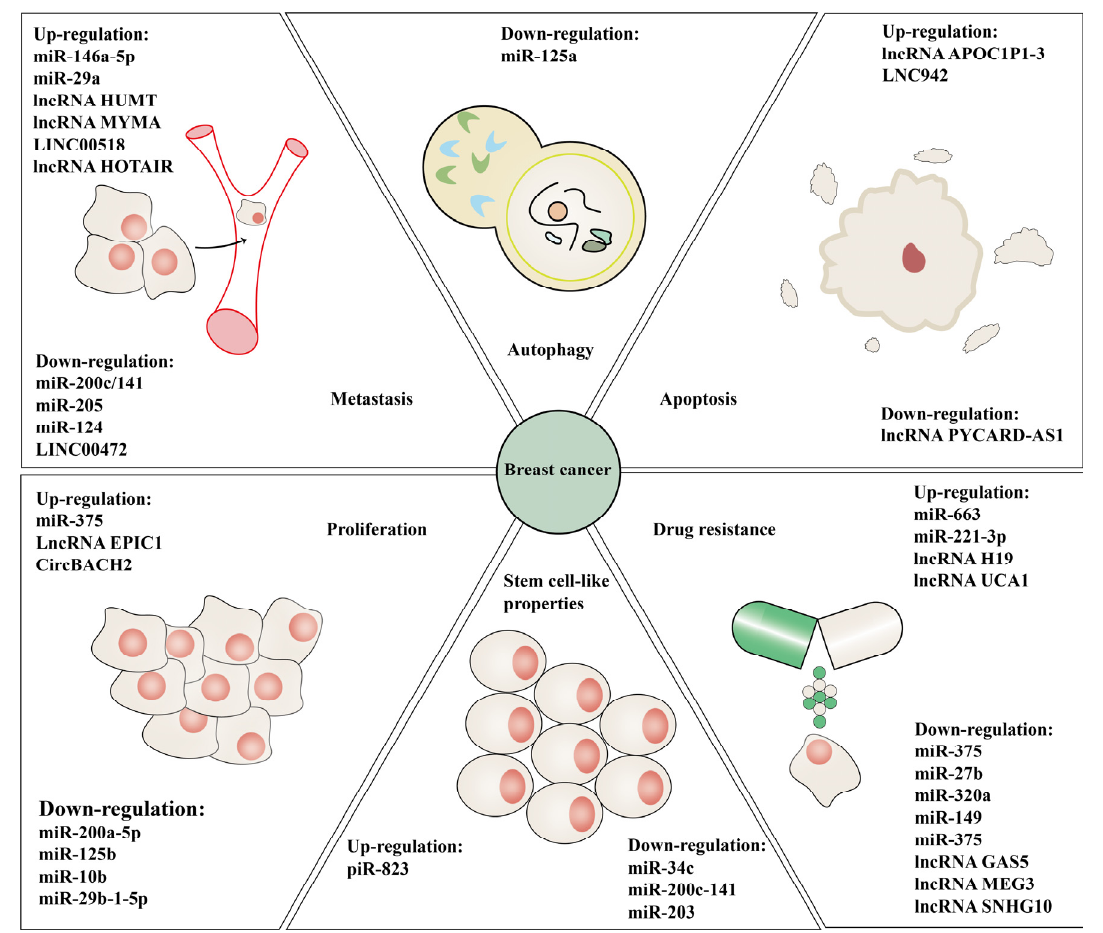
Figure 4. MiRNA, lncRNA, circRNA, and piRNA are associated with proliferation, apoptosis, metastasis, autophagy, stemness, and drug resistance in BC. Dysregulation of ncRNAs due to aberrant crosstalk between methylation modification and ncRNAs is associated with malignant behavior in BC, such as proliferation (miR-375, lncRNA EPIC1, circBACH2. miR-200a-5p, miR-125b,